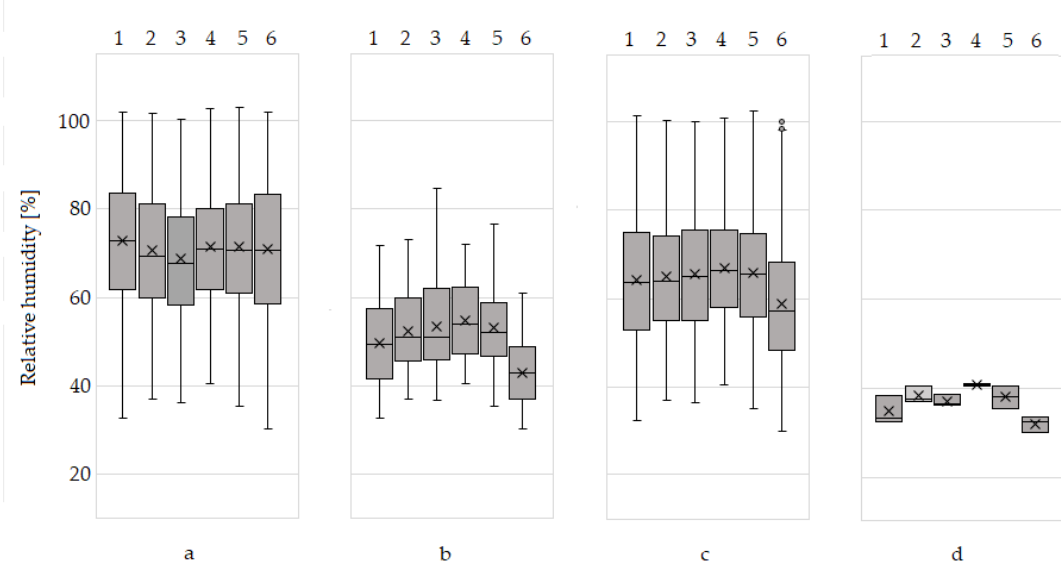
Figure A2. Boxplots with mean (x), median (horizontal line), 25 and 75 percentiles, and minima and maxima of relative air humidity in the study period at the six measuring points, given for all measured values ( a ), the recorded daily minima ( b ), the daytime means recorded in cloudless periods ( c ), and the absolute minima recorded ( d ). The six measuring points are 1 = Oa, 2 = Oa/Be(lo), 3 = Oa/Be(up), 4 = Be, 5 = Be(N), and 6 = Ga.